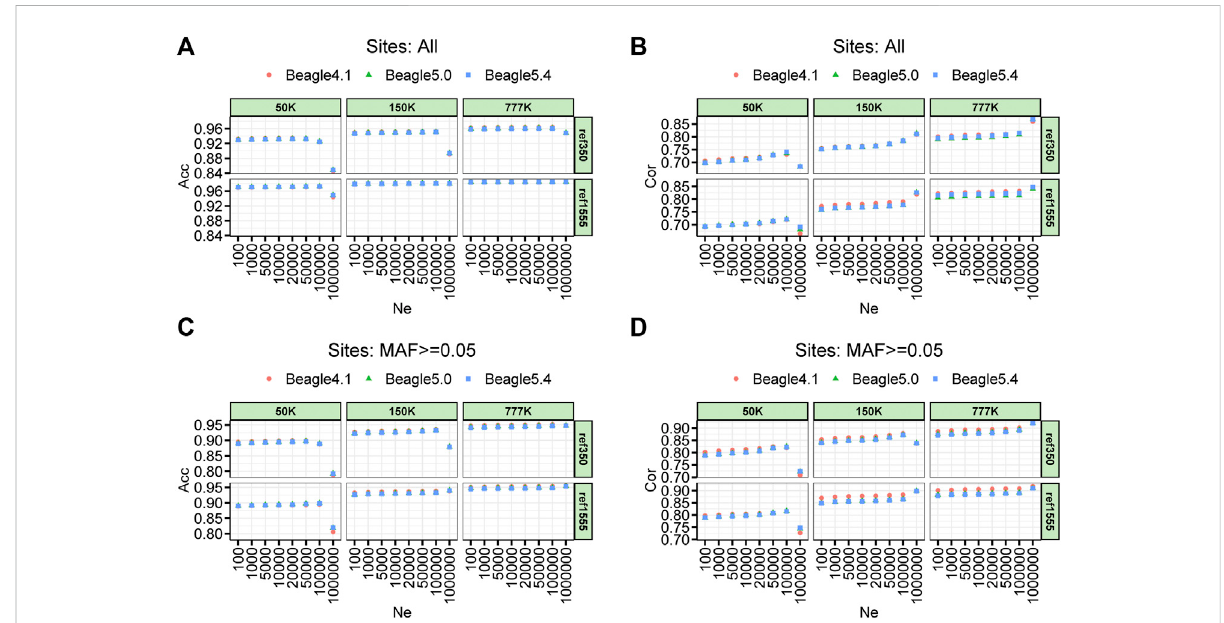
FIGURE 3 Accuracy of imputation for three density BeadChip chips, two reference population sizes and three imputation software with a range of effective population size (Ne) sets in cattle. (A) Imputation accuracy measured by the genotype concordance (Acc). (B) Imputation accuracy measured by the correlation (Cor) (C,D) corresponds to (A) and (B) with minor allele frequency sites less than 0.05